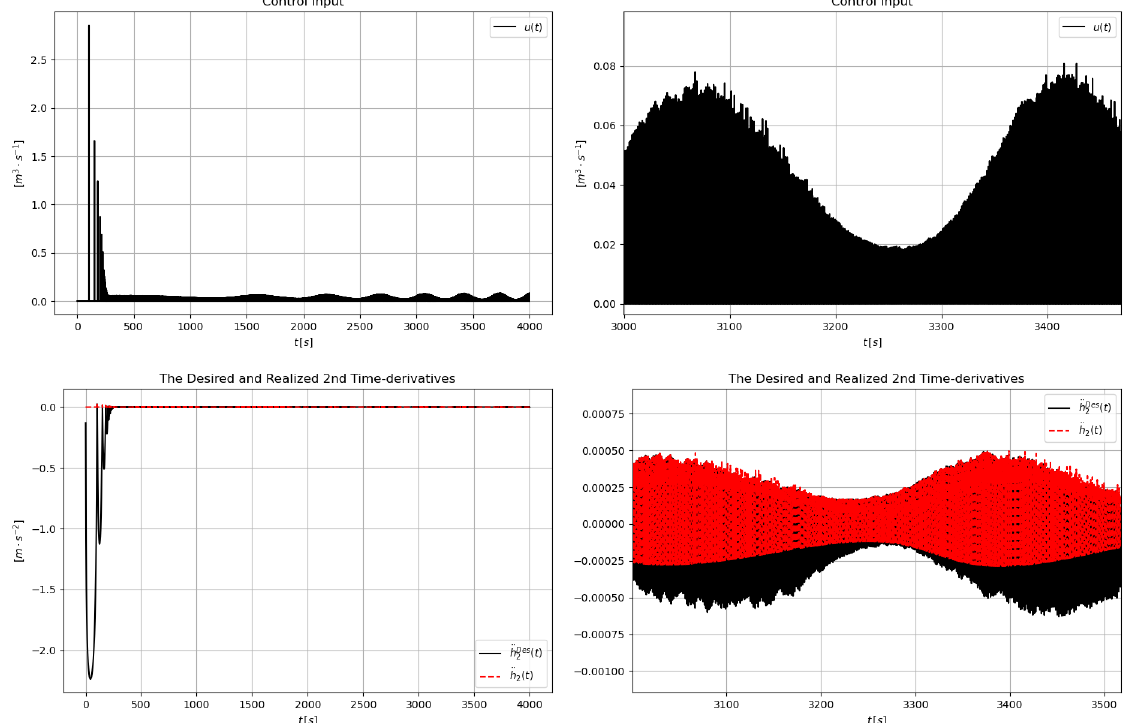
Figure 8. For Λ max = 5.5 and T = 5 ∆ t with adaptivity: The adaptive control input with its zoomed in excerpt (upper Left & Right Sides) and the second time-derivatives with its zoomed in excerpt (below Left & Right